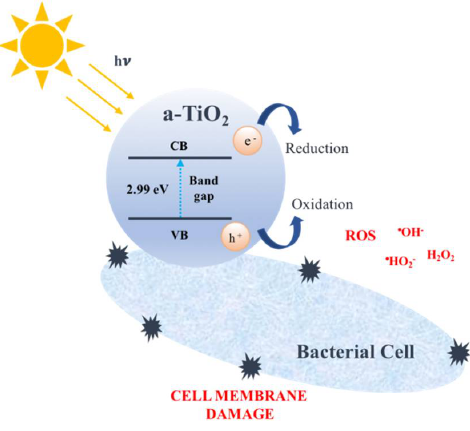
Figure 4. ROS damage bacterial cell membranes.